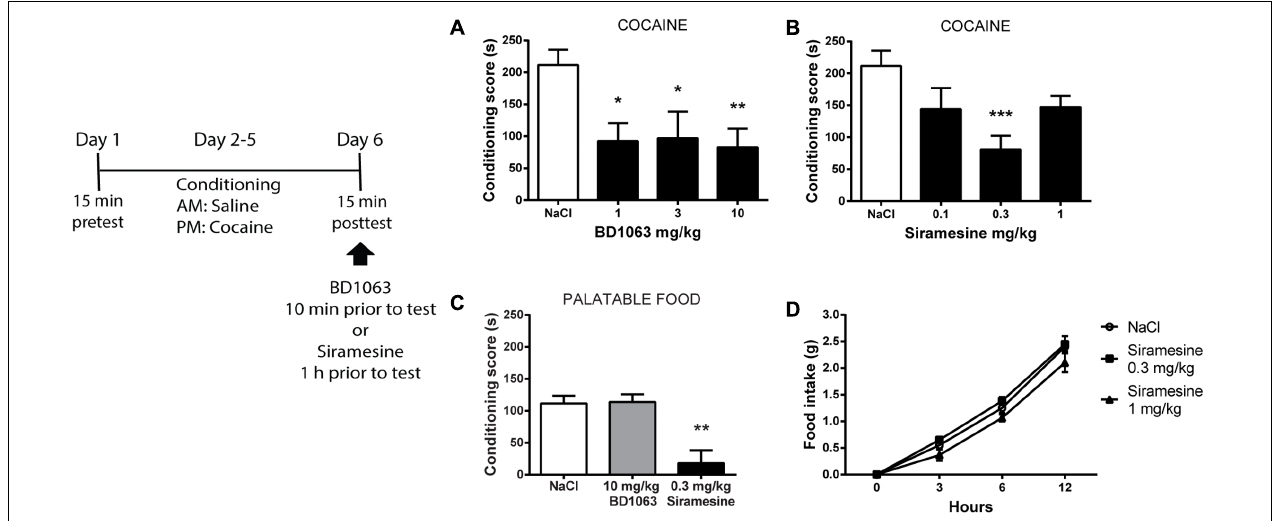
FIGURE 3 | Expression of cocaine-induced place preference. Both, BD 1063 (A) ( n = 12, 7, 9, and 13) and Siramesine (B) ( n = 12, 8, 10, and 9) attenuate the expression of cocaine place preference as represented with mean ± SEM. CPP scores from NaCl-treated control mice were pooled and represented in both graphs.